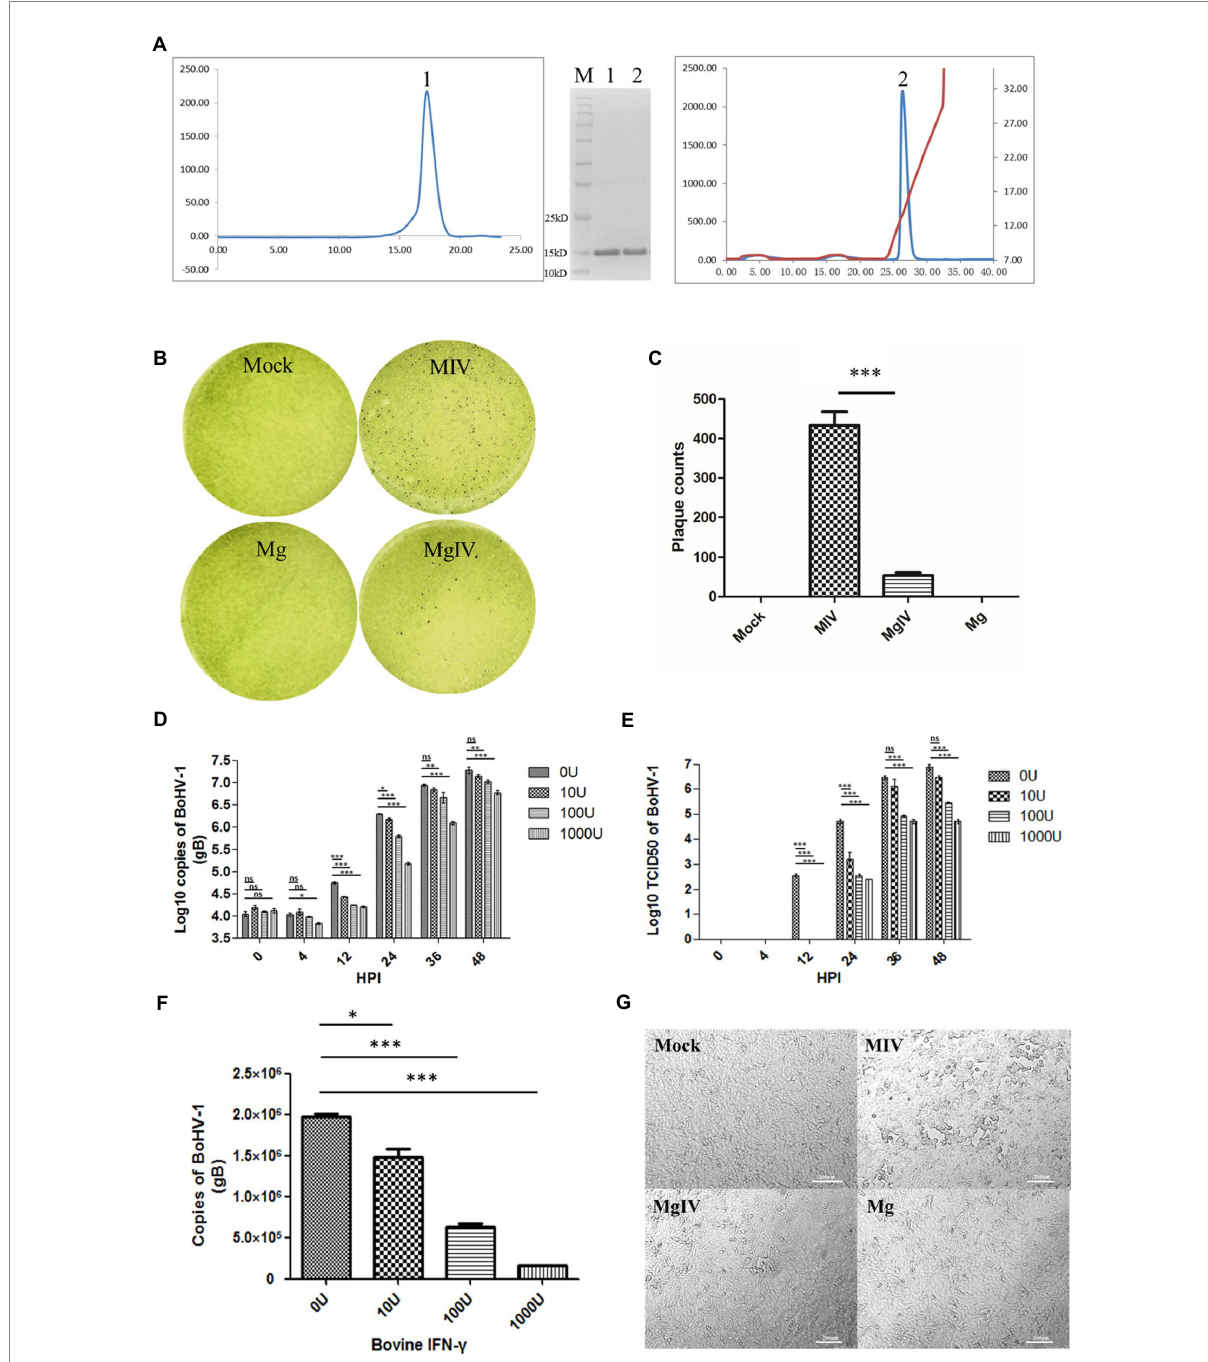
FIGURE 1 Preparation and antiviral activity of BoIFN- γ . (A) The expression and purification of BoIFN- γ , Left, Gel-filtration profile of the BoIFN- γ . Right, Results of further purification of the folded BoIFN- γ by anion-exchange chromatography. The protein was eluted at NaCl concentration of 12.0%–15.0%. Inset, reduced SDS-PAGE gel (15%) of the corresponding purified protein (14.2 kDa). Lane M contains molecular-weight markers (labelled in kDa). (B,C) Plaque reduction test of the BoIFN- γ . Mock represents uninfected MDBK cells, MIV represents MDBK cells infected with BoHV-1 and pre- treated with PBS, Mg represents MDBK cells pre-treated with BoIFN- γ only, MgIV represents MDBK cells infected with BoHV-1 and pre-treated with BoIFN- γ . Viral plaques were counted using 0.1% toluidine blue in saline, and reverse the colour to show plaques more clearly. The data were analysed using SPSS software and one-way ANOVA, and the graph was made using GraphPad Prism 5.0. *** represented statistically statistically differences ( p < 0.001). ** represents statistically significant differences ( p < 0.01). * represents statistically very significant differences ( p < 0.05). (D) Replication curves of BoHV-1 in MDBK cells pre-treated with different doses of BoIFN- γ (10, 100, and 1,000 U/ml) detected use FQ-PCR. (E) Replication curves of BoHV-1 in MDBK cells supernatants pre-treated with different doses of IFN- γ (10, 100, and 1,000 U/ml) detected use TCID 50 . (F) Replication of BoHV-1 in MDBK cells at 24 h poster infection pre-treated with different doses of BoIFN- γ (10, 100, and 1,000 U/ml) detected use FQ-PCR. (G) Changes in cellular morphology at 24 HPI. MIV is MDBK infected with BoHV-1 only, MgIV is MDBK pre-treated 1,000 U/ ml BoIFN- γ 12 h and then infected BoHV-1, Mg is MDBK pre-treated BoIFN- γ without BoHV-1 infection, Mock is MDBK cell